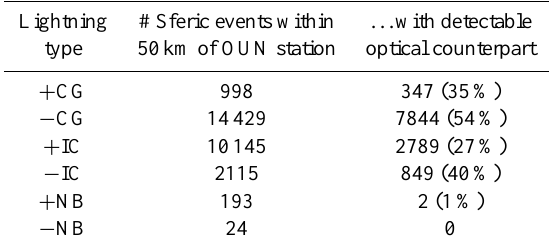
Table 5. Ground-based sferic–optical data sample. Lightning # Sferic events within ...with